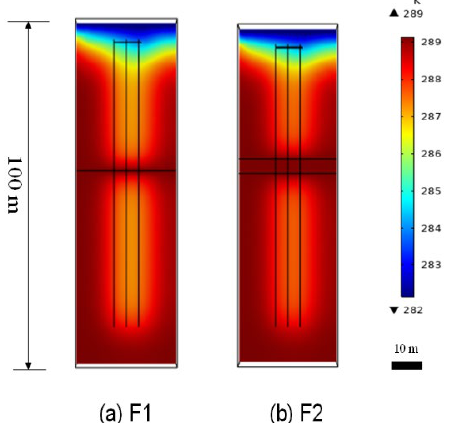
Figure 10. The temperature field in the Y-Z plane at X = 20 m at the 26th month: (NF) rock mass without cracks; (F1) one horizontal crack; (F2) two horizontal fractures.